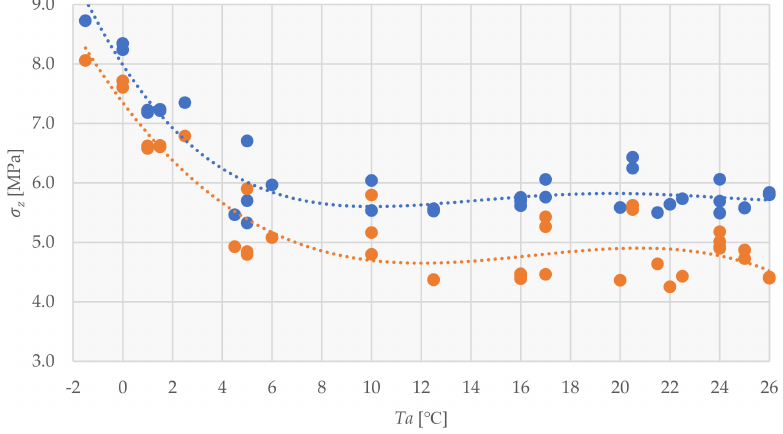
Figure 26. Extreme values of σ z [MPa] as a function of ambient temperatures T a [ ◦ C] (blue—monolith length 20.0 m; orange—monolith length 15.0